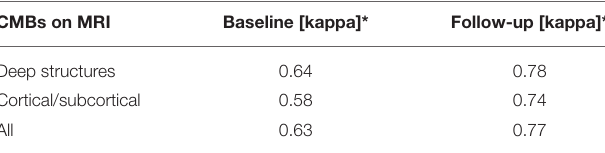
TABLE 5 | Inter-observer agreement for the MRI assessment of CMBs.